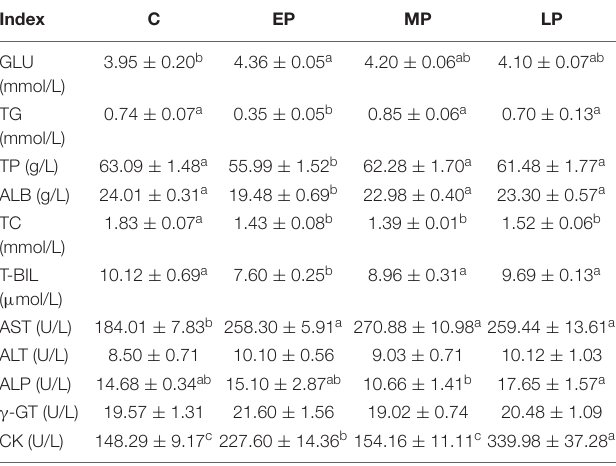
TABLE 1 | Serum biochemical parameters in Dezhou donkeys during different gestation